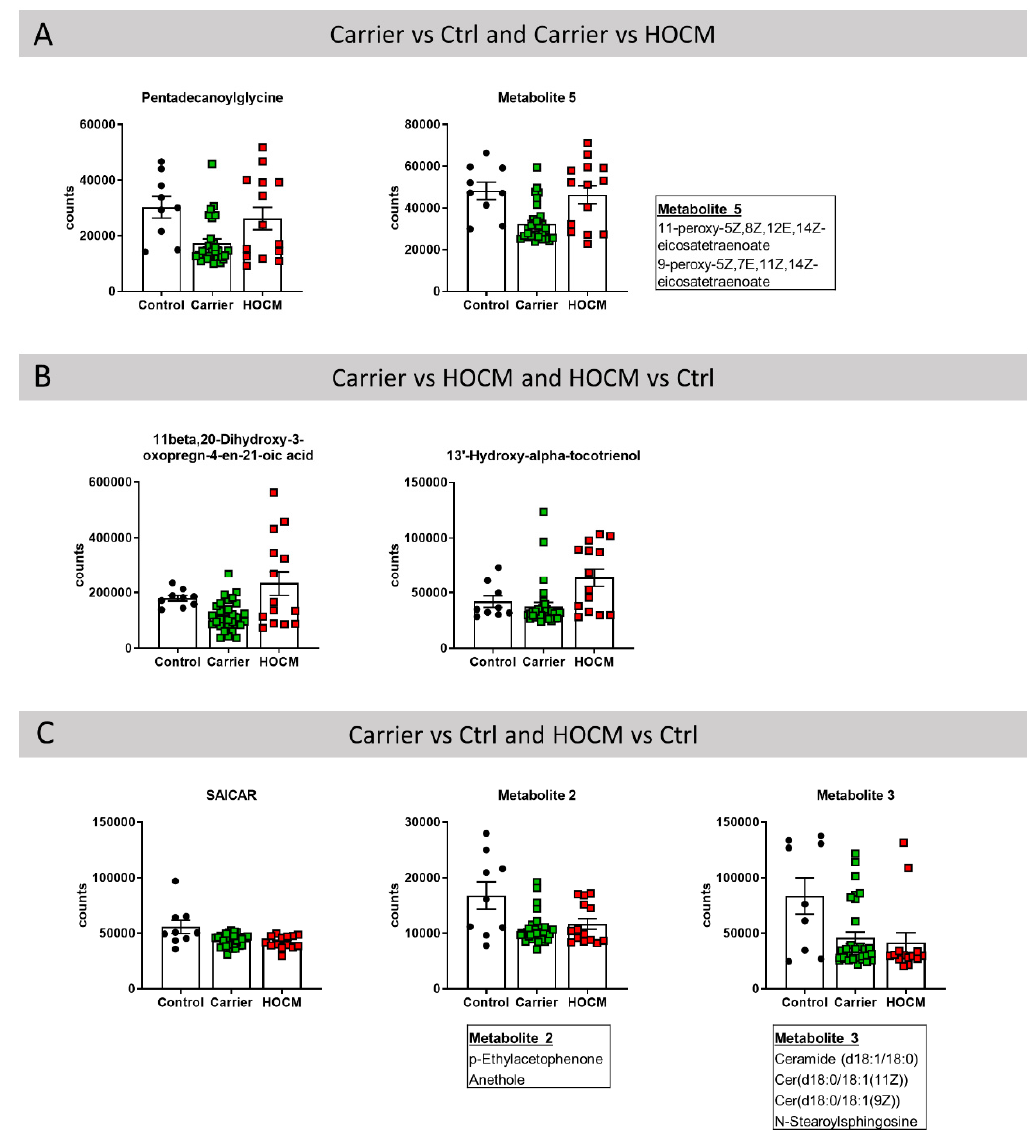
Figure 3. Metabolites that were among the 30 most important metabolites in distinguishing the groups in the ( A ) Carrier vs. Ctrl and Carrier vs. HOCM comparison, ( B ) Carrier vs. HOCM and HOCM vs. Ctrl comparison and ( C ) Carrier vs. Ctrl and HOCM vs. Ctrl comparison.